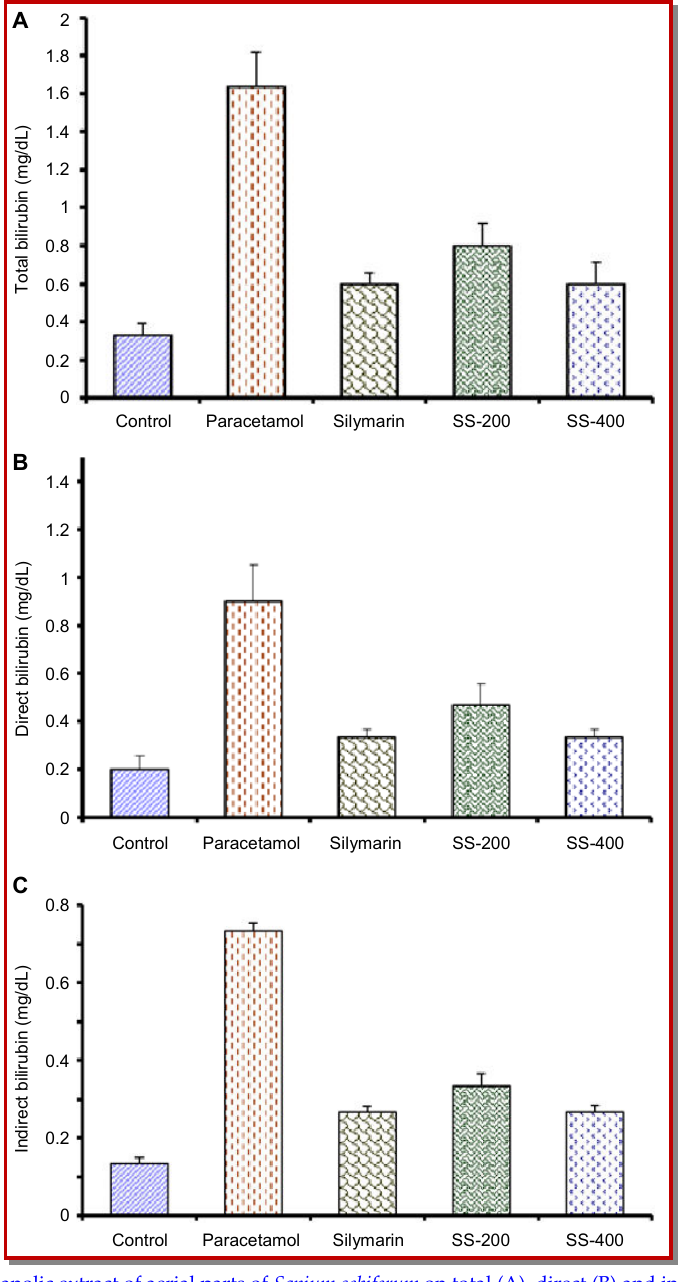
Figure 2: Effect of the methanolic extract of aerial parts of Sapium sebiferum on total (A), direct (B) and indirect (C) bilirubin. SS-200; 200 mg/kg of S. sebiferum , SS-400; 400 mg/kg of S.